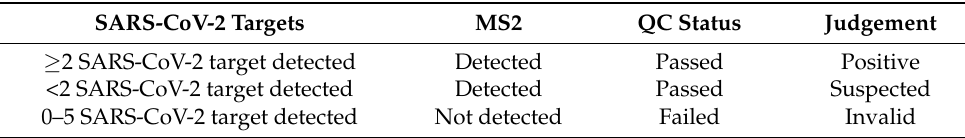
Figure 4. An example of MassARRAY ® System data obtained for a positive sample with all SARS-CoV-2 targets detected ( A ). The positions of all extension primers and analyte peaks are labeled with the same color. Mass is in daltons (Da). Zoomed spectra of obtained amplicons are shown in ( B ). UEP — unextended primer. Table 2. Rules for sample qualification and virus detection status.